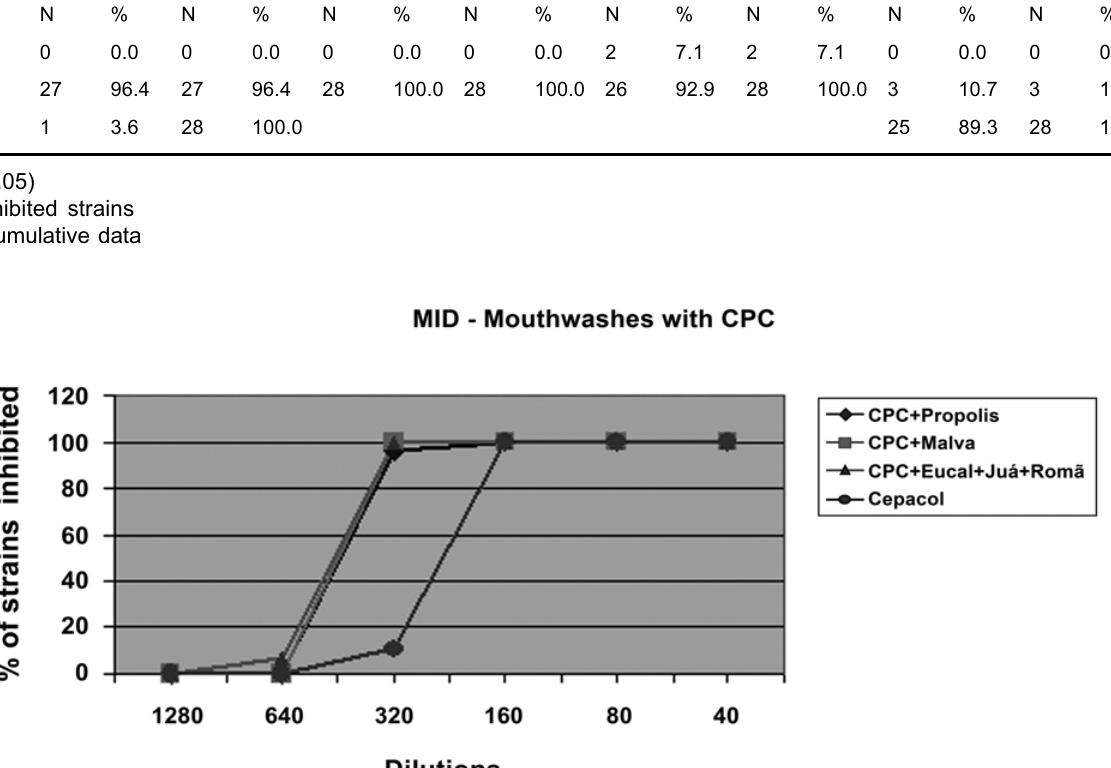
FIGURE 1- Graph depicting the MID values obtained for each